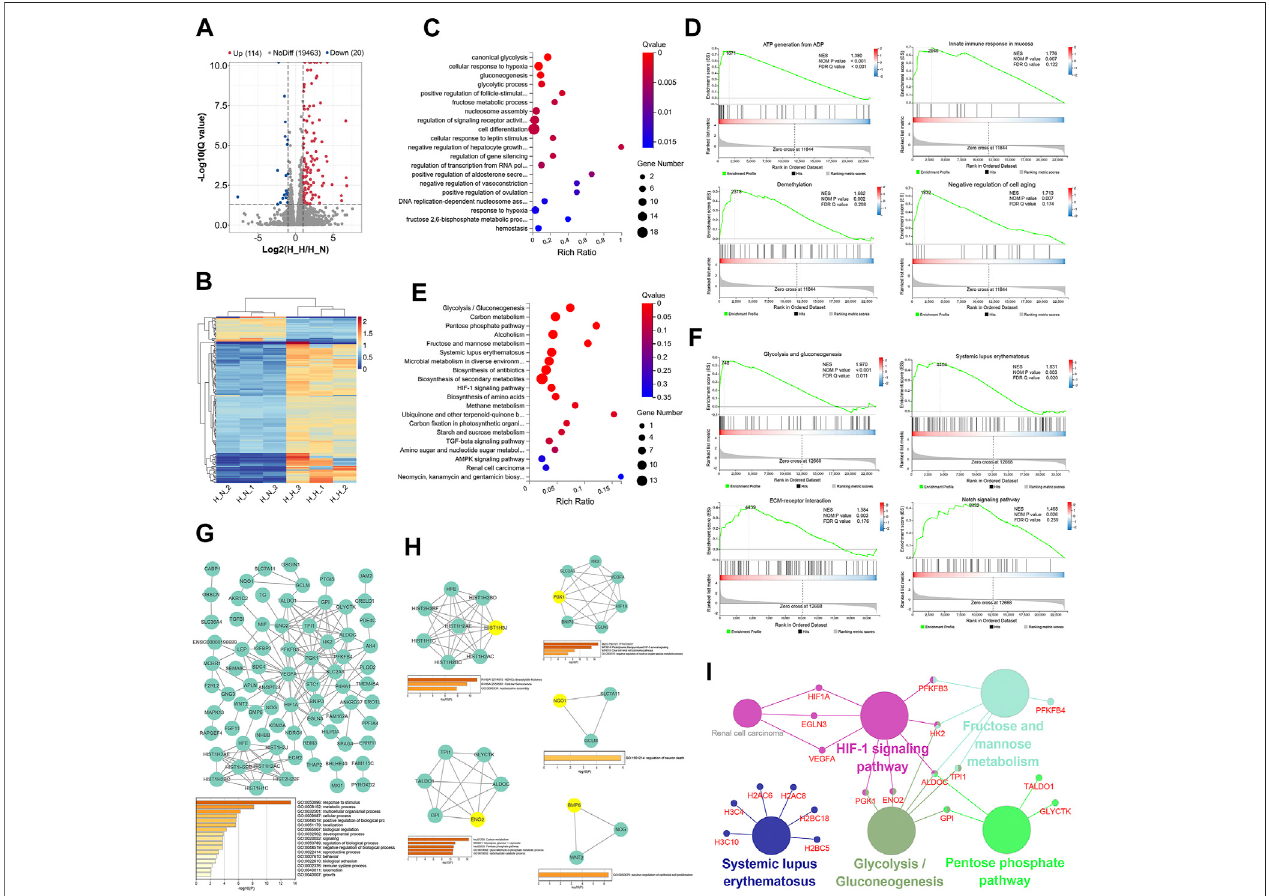
FIGURE 1 | Identi fi cation and functional analysis of differentially expressed genes (DEGs) in normoxia-treated healthy hPDLSCs (H_N) compared with hypoxia- treatedhealthy hPDLSCs (H_H). (A) Volcano map ofDEGs analyzed byDESeq2 (|log2FC| ≥ 1; Qvalue ≤ 0.05);the red dotsrepresentupregulated DEGs, thegreen dots representdownregulatedDEGs,andthegraydotsrepresentgenesthatdidnotshowsigni fi cantdifferentialexpression. (B) Expressionheatmapofeachsamplewiththe expression standardized by log (expression+1); each row represents a gene, each column represents a sample, and the colors in the panels represent the relative expression levels, with blue indicating low expression and red indicating high expression. (C) GO enrichment analyses of the DEGs. (D) Gene set enrichment analysis (GSEA)ofbiologicalprocesses,including ATPgenerationfromADP,innateimmuneresponseinmucosa, demethylation, andnegativeregulationofcellaging. (E) KEGG enrichment analyses of the DEGs. (F) GSEA of KEGG, including glycolysis/gluconeogenesis, systemic lupus erythematosus, ECM-receptor interaction and the Notch signaling pathway. (G) PPI network of the DEGs and the three most highly correlated hub genes. (H) Signi fi cant modules in the PPI network and the most highly correlated hub gene in each module; the hub genes are shown in yellow. (I) Network of KEGG pathway enrichment results determined by ClueGO; the large circles are pathways, their size depends on the p value, and the small circles are the genes found in the pathway.